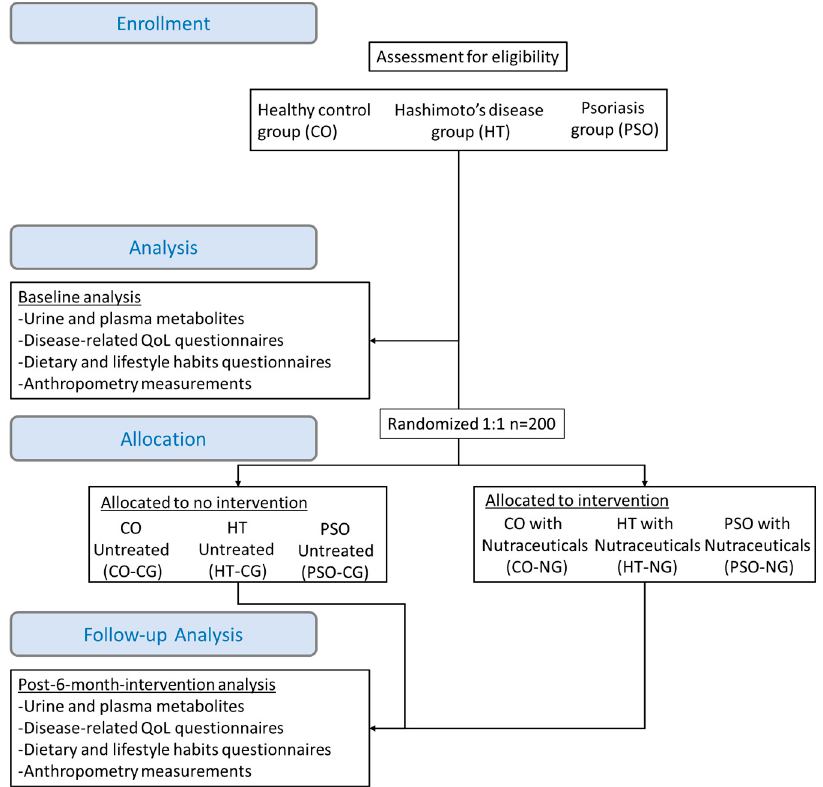
Figure 1. Study flow chart including patients’ enrollment steps, baseline assessment measurements, random allocation to intervention and post-intervention measurements.; QoL: quality of life; NG: nutraceuticals group; CG: control group .